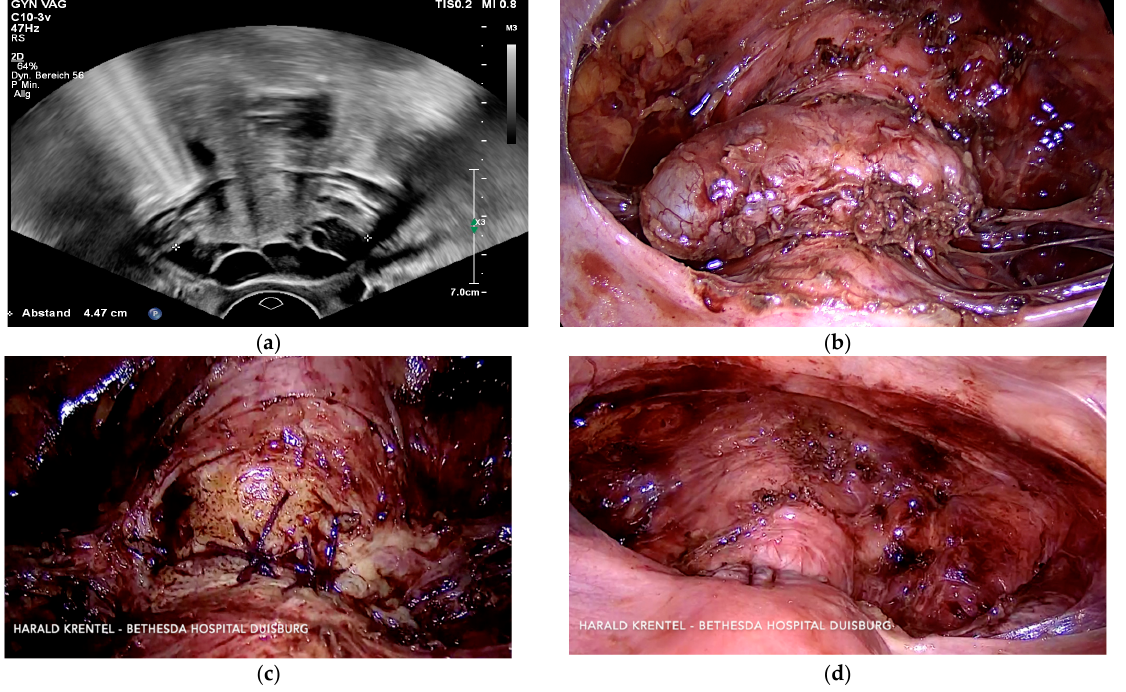
Figure 6. ( a ) Transversal transvaginal ultrasound showing a large isthmocele in the anterior uterine wall; ( b ) laparoscopic view of isthmocele after deperitonealisation and detachment of bladder; ( c ) laparoscopic suture—first layer; ( d ) laparoscopic suture—second layer.